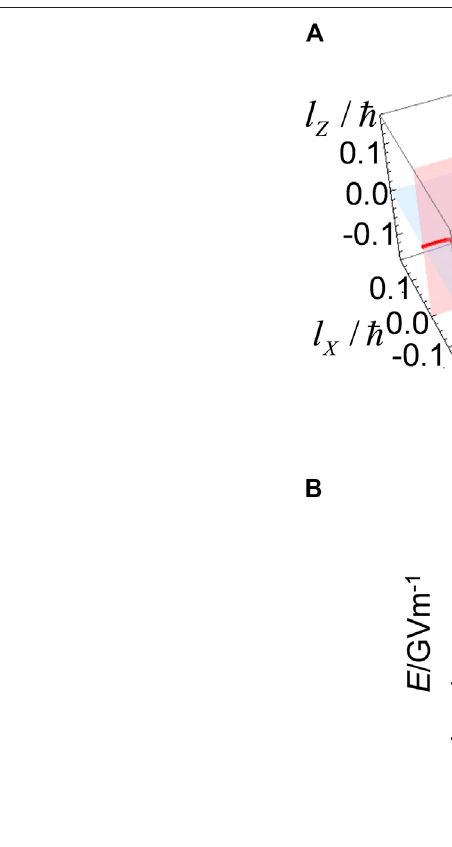
Frontiers in Physics |